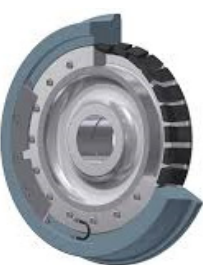
Figure 3. Locomotive wheel with resilient layer inserted between the hub and tread [28].